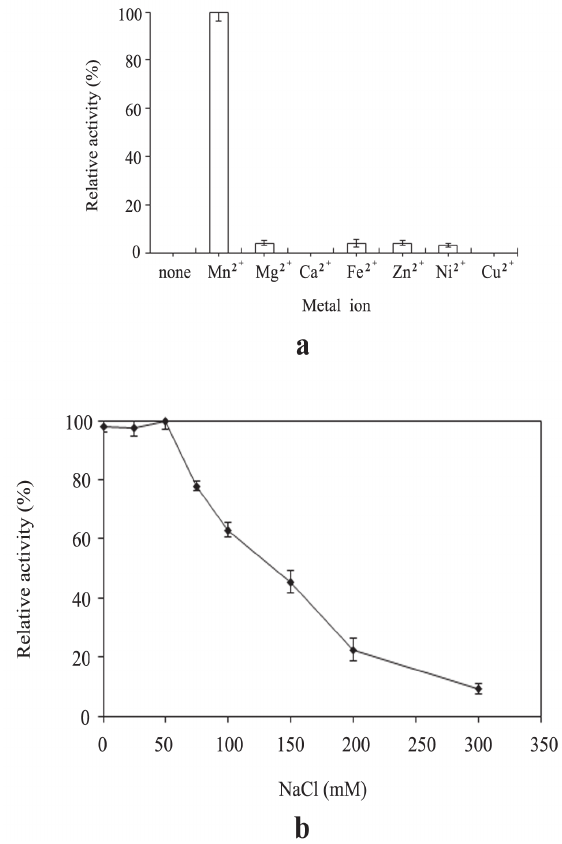
Figure 5 - ( a ) Effect of metal ions on the nuclease activity of the purified StoNurA. The concentration of all metal ions were adjusted to 5 mM. ( b ) Effect of NaCl concentration on the nuclease activity of the purified StoNurA. The nuclease activities of the treated samples were determined by the standard assay using ssDNA as the substrates. Each value was calculated based on the results of three independent